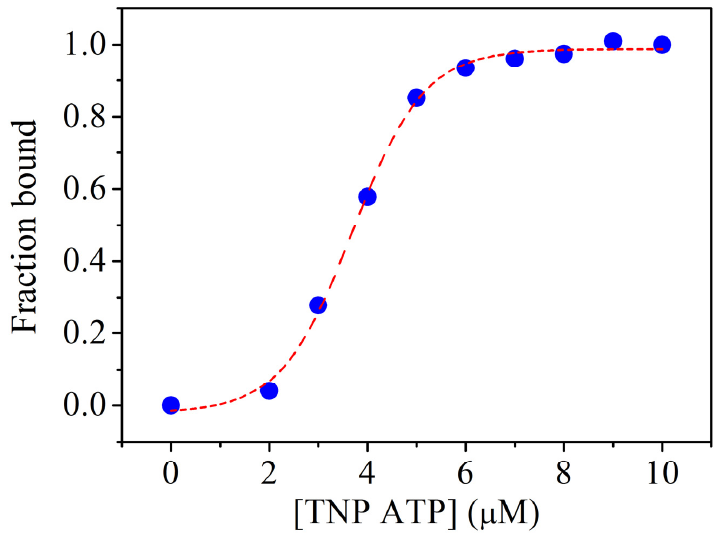
Figure 5. Binding of TNP-ATP to Tm -MreB shows saturation. The fluorescence intensity of TNP-ATP was measured in the presence of 20 µ M Tm -MreB at different concentrations. In the case of saturation, no more binding is possible, so it was plotted as the maximum of the bound fraction. The affinity of Tm -MreB for TNP-ATP was calculated as half-maximum of saturation and determined to be 3.69 µ M.